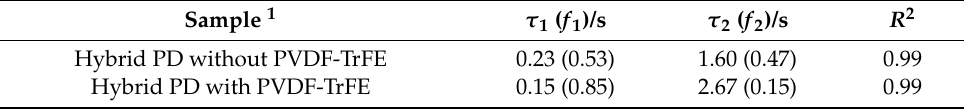
Figure 3. ( a ) Responsivity versus voltage plot for hybrid PD with PVDF-TrFE under forward bias with various light intensity. Photocurrent versus time plot for hybrid PD (b ) without PVDF-TrFE and ( c ) with PVDF-TrFE. Table 1. Photocurrent decay profile for hybrid PD without PVDF-TrFE and with PVDF-TrFE.